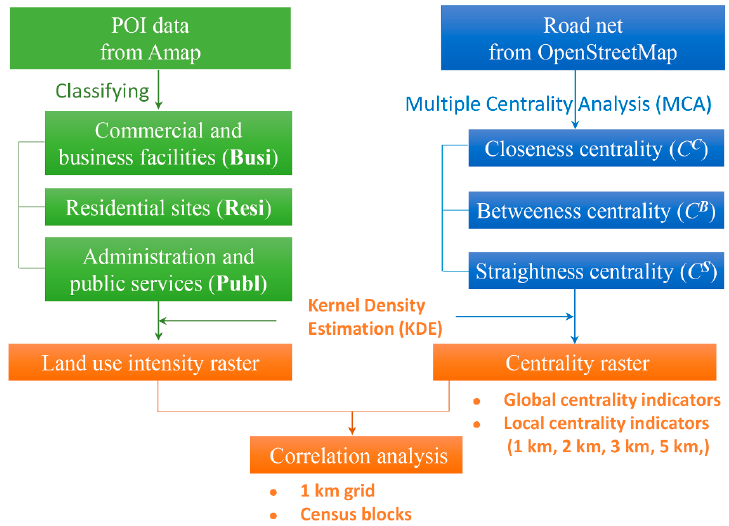
Figure 4. Flowchart of analysis of interrelationship between street centralities and POI-based urban land use intensities.